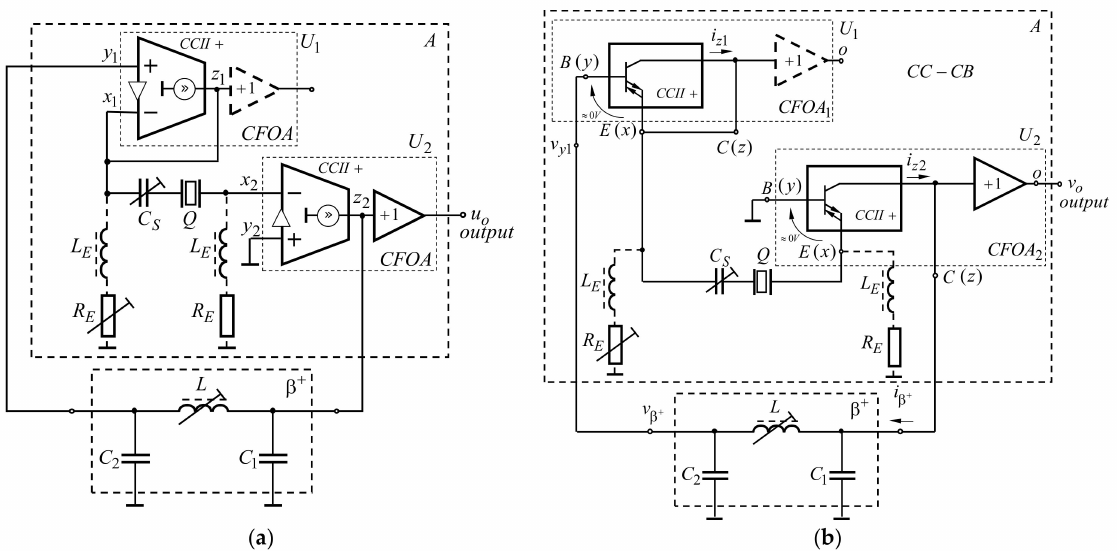
Figure 6. Two-stage oscillator, with a quartz-crystal unit connected between the x -terminals of two monolithic CCIIs (QO3): ( a ) circuit diagram with two CCIIs, represented as parts of four-terminal CFOAs; ( b ) circuit diagram with two CCIIs, represented as a cascade (common collector–common base)